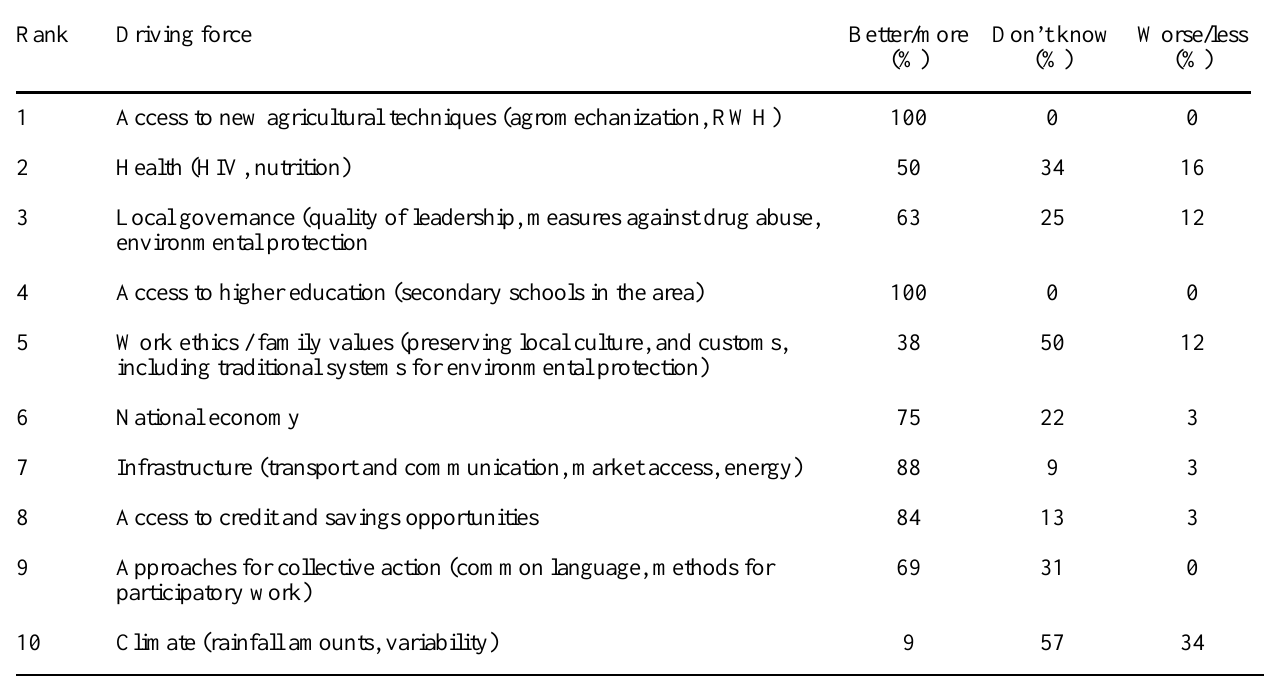
Table 2. Ranking of driving forces. Access to new agricultural techniques was ranked as the most important driving force in the area, followed by health and local governance. The table also shows the participants’ perception of how these factors will change in the coming decades. This is expressed as percentage of participants assessing the driving forces to become better/more, or worse/less, alternatively who don’t know, in the future. N =